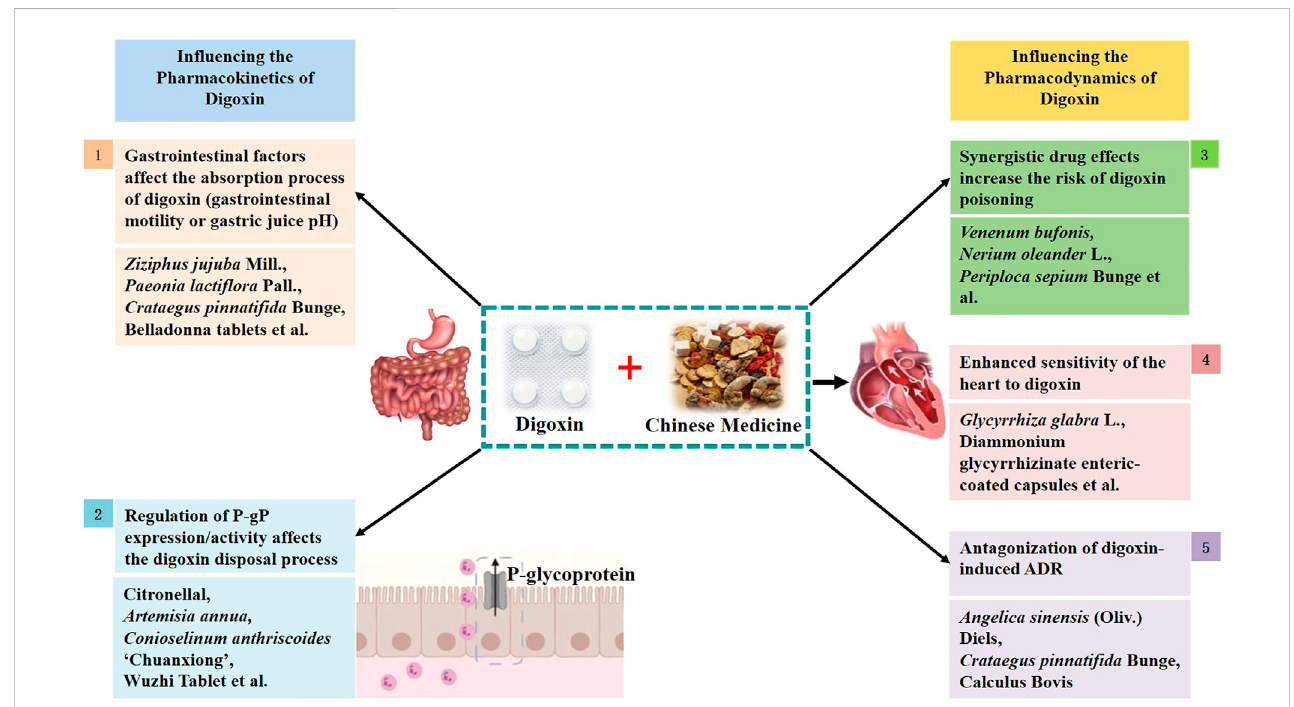
FIGURE 1 Schematic diagram of the mechanism of action between digoxin and traditional Chinese